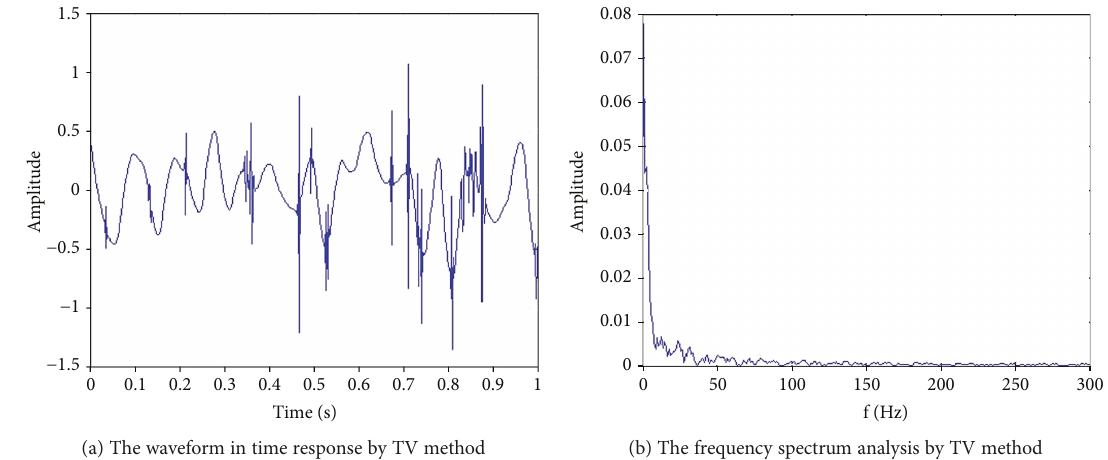
Figure 5: The result provided by the typical total variation (TV) denoising.